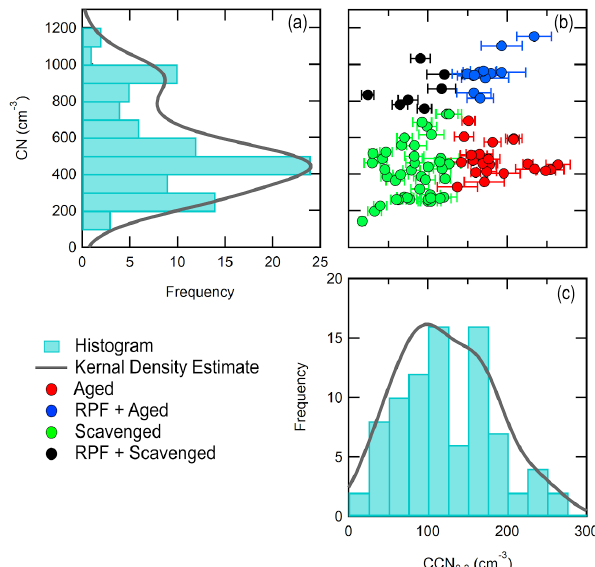
Figure 2. Histograms and kernel density estimates of (a) CN con- centrations and (c) MBL CCN 0 . 3 (CCN concentration at 0.3% su- persaturation). (b) MBL CN and CCN 0 . 3 . Measurements are di- vided into four particle regimes based on the observed bimodal dis- tributions of both CN and CCN 0 . 3 . Error bars represent the standard